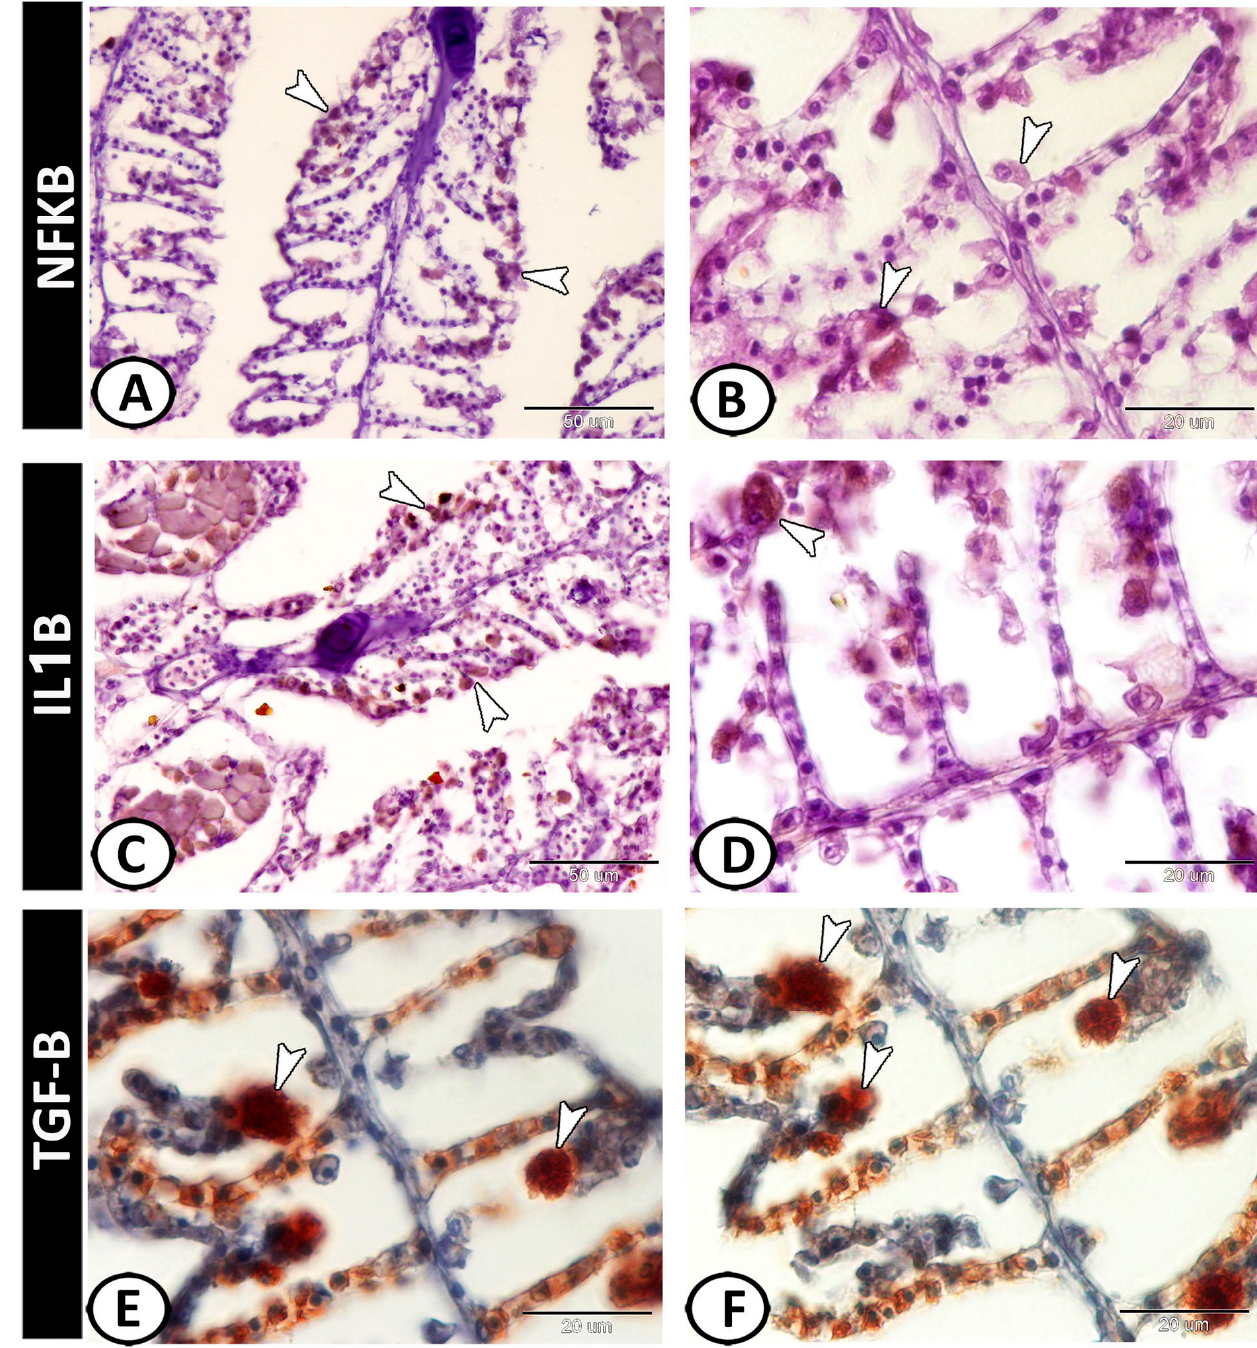
Figure 5. Immunohistochemistry of IL-1 β , NF- κ B, and TGF-B. ( A , B ) IL-1 β showed immunoreactivity in the monocytes and macrophages of the gill filaments (arrowheads). ( C , D ) NF- κ B showed im- munoreactivity in the inflammatory cells (including monocytes and macrophages) of the gill filaments (arrowheads). ( E , F ) Macrophages expressed TGF-B (arrowheads). The stem cells expressed SOX9 (Figure 6A,B), myostatin (Figure 6C,D), and Nrf2 (Figure 6E,F). Moreover, neuroendocrine cells expressed S100 protein (Figure 7A–C). Chlo- ride cells showed positive immunoreactivity to S100 protein (Figure